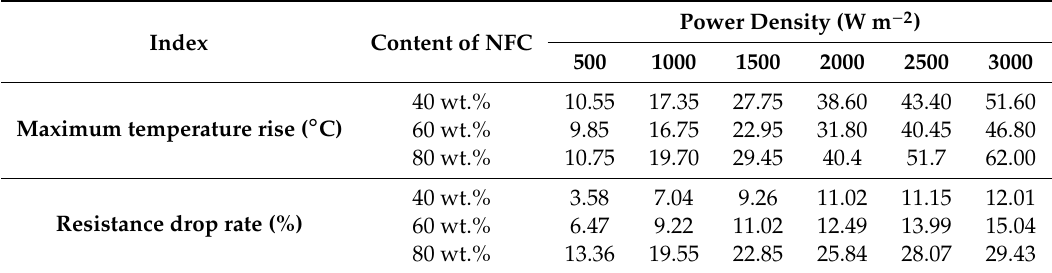
Table 3. Maximum temperature rise and resistance drop rate of electrothermal CCGA with different NFC contents under different power density.